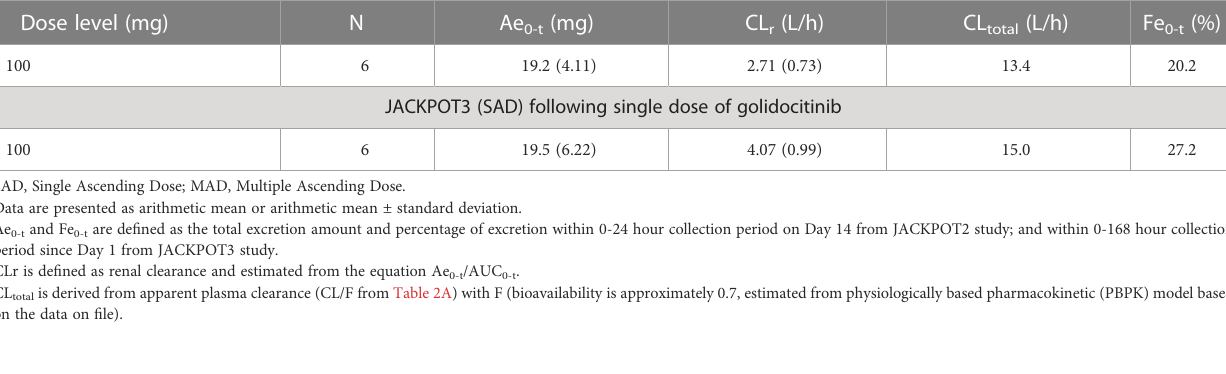
TABLE 2C Statistical analysis of the effect of race on the pharmacokinetic parameters of golidocitinib - single dose in healthy